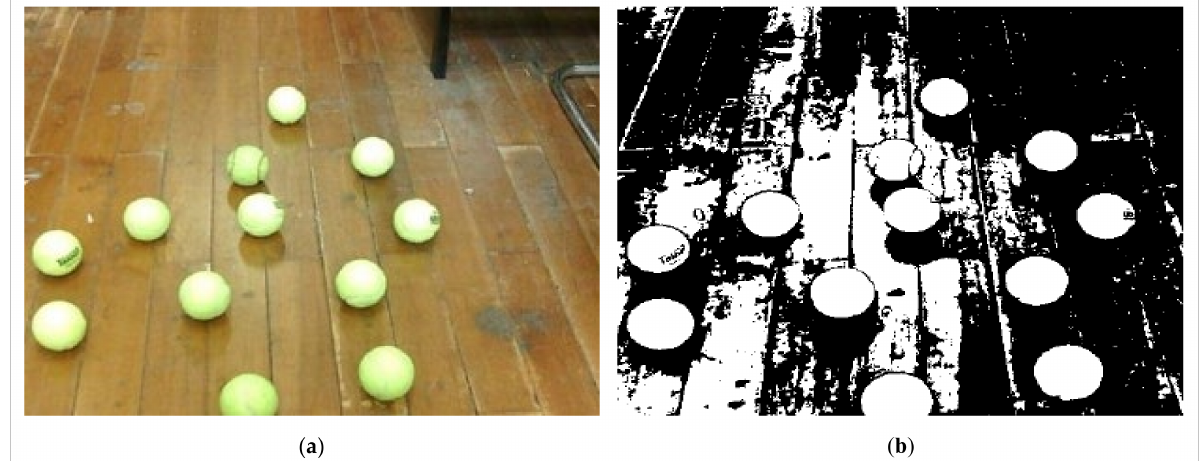
Figure 5. HSV color space-based recognition of tennis balls. ( a ) Original image; ( b ) recognition effect picture.